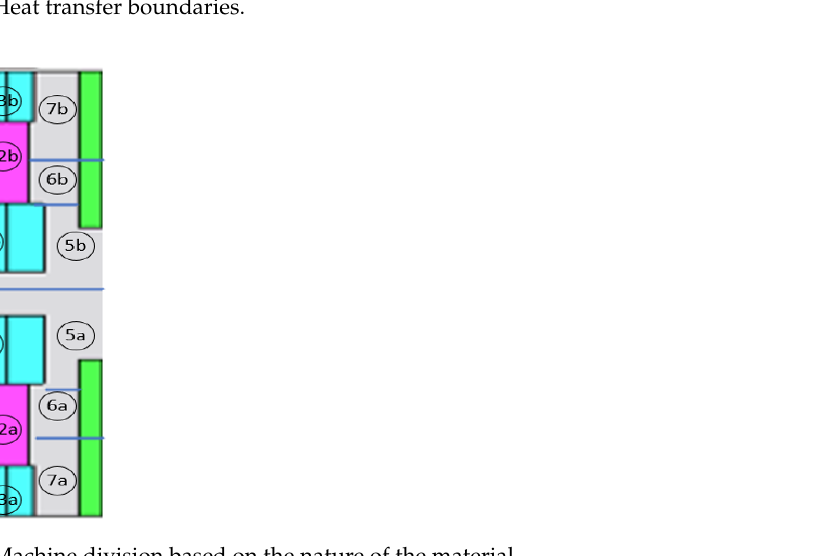
Figure 26. Heat transfer boundaries.